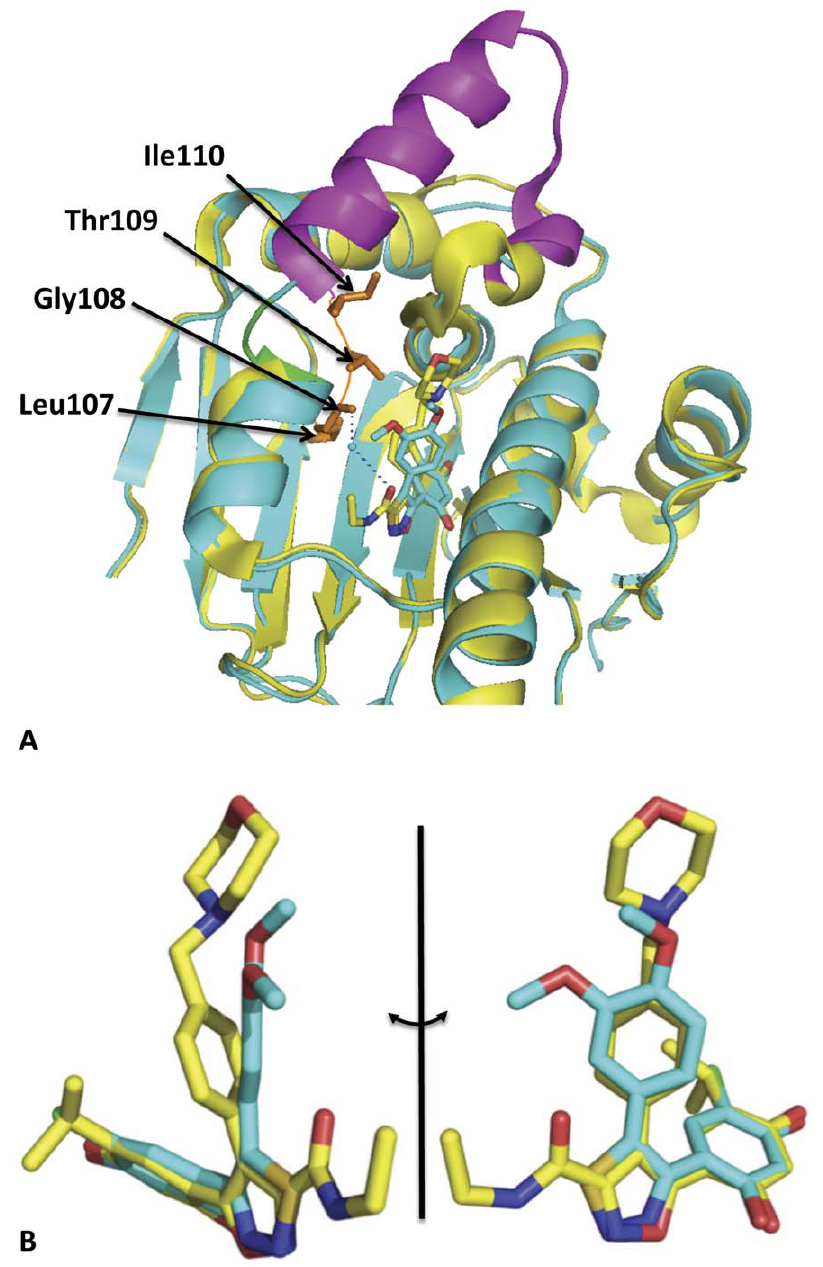
Figure 3. PyMol cartoons of the structure of human Hsp90-drug complexes. ( A ), PyMol cartoon showing ICPD 34 (cyan) and NVP-AUY922 (yellow and magenta) bound to the N-terminal domain of human Hsp90 a . The magenta region of the NVP-AUY922-Hsp90 a complex represents the unstructured region of the ICPD 34-Hsp90 a complex. The mobile loop region interacting with NVP-AUY922 is shown in gold. Water molecules are shown as cyan colored spheres and hydrogen bonds as dotted blue lines. The 3-methoxy group of ICPD 34 causes the loop represented by Asn 105 to Ile 110 to adopt an alternative conformation, which moves from the gold to green conformation. ( B ), Two orthogonal views of the superimposition of ICPD 34 (Cyan) and NVP-AUY922 (yellow) showing that the compounds bind with overall similarity, except for the morpholino group of NVP- AUY922 and the dimethoxyphenyl group of ICPD 34. The structures for ICPD 34 and NVP-AUY922 were obtained at 2.5 and 2.0 A˚ resolution, respectively. For atomic coordinates and structure factors, see PDB codes 2YI5 and 2VCI, respectively.